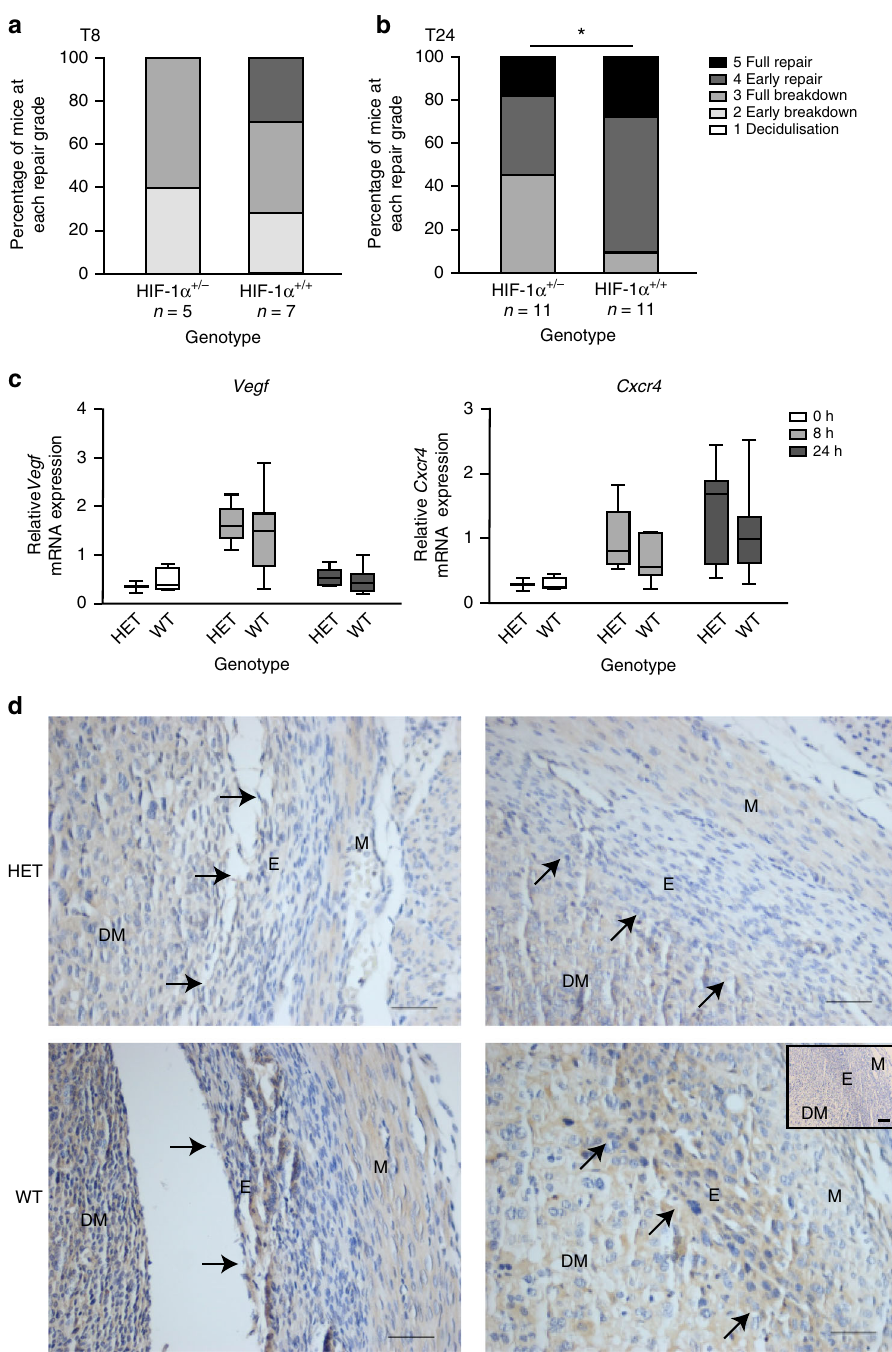
Fig. 4 HIF-1 α heterozygote mice display delayed endometrial repair following progesterone withdrawal. a Endometrial histological breakdown/repair score at 8 h following P withdrawal (T8) and b at 24 h following P withdrawal (T24) in HIF-1 α heterozygote (HET, HIF-1 α +/ − ) versus wild type (WT, HIF-1 α +/+ mice. Graphs represent percentage of mice at each histological grade per experimental group. * P < 0.05, unpaired t -test. c Relative mRNA concentration of Vegf and Cxcr4 in uterine tissue from HET versus WT mice at T0 ( n = 2/4), T8 ( n = 5/7) and T24 ( n = 11/11). Box represents upper and lower quartiles with horizontal line representing the median, whiskers represent minimum and maximum values. d Carbonic anhydrase IX immunohistochemical staining in HIF-1 α heterozygote (HET) and wild-type (WT) mice. Arrows represent area of endometrial separation. M myometrium, E endometrium, DM decidualised mass. Inset = negative control. Scale bar = 100 μ